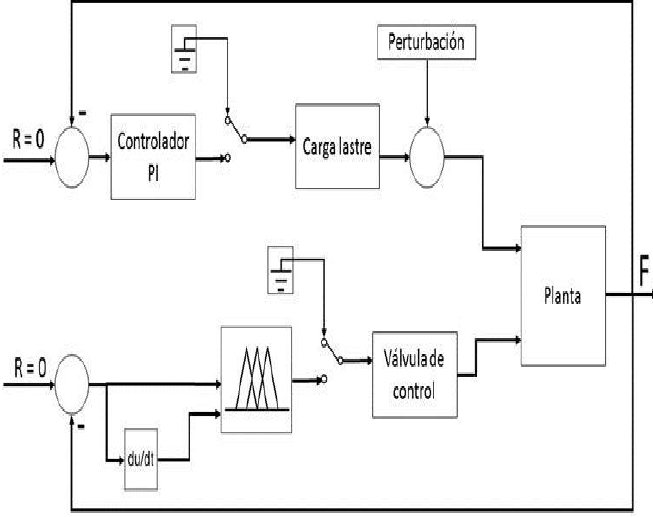
Figura 2: Simulación en Matlab de la propuesta. Fuente: Los Autores, (2018).